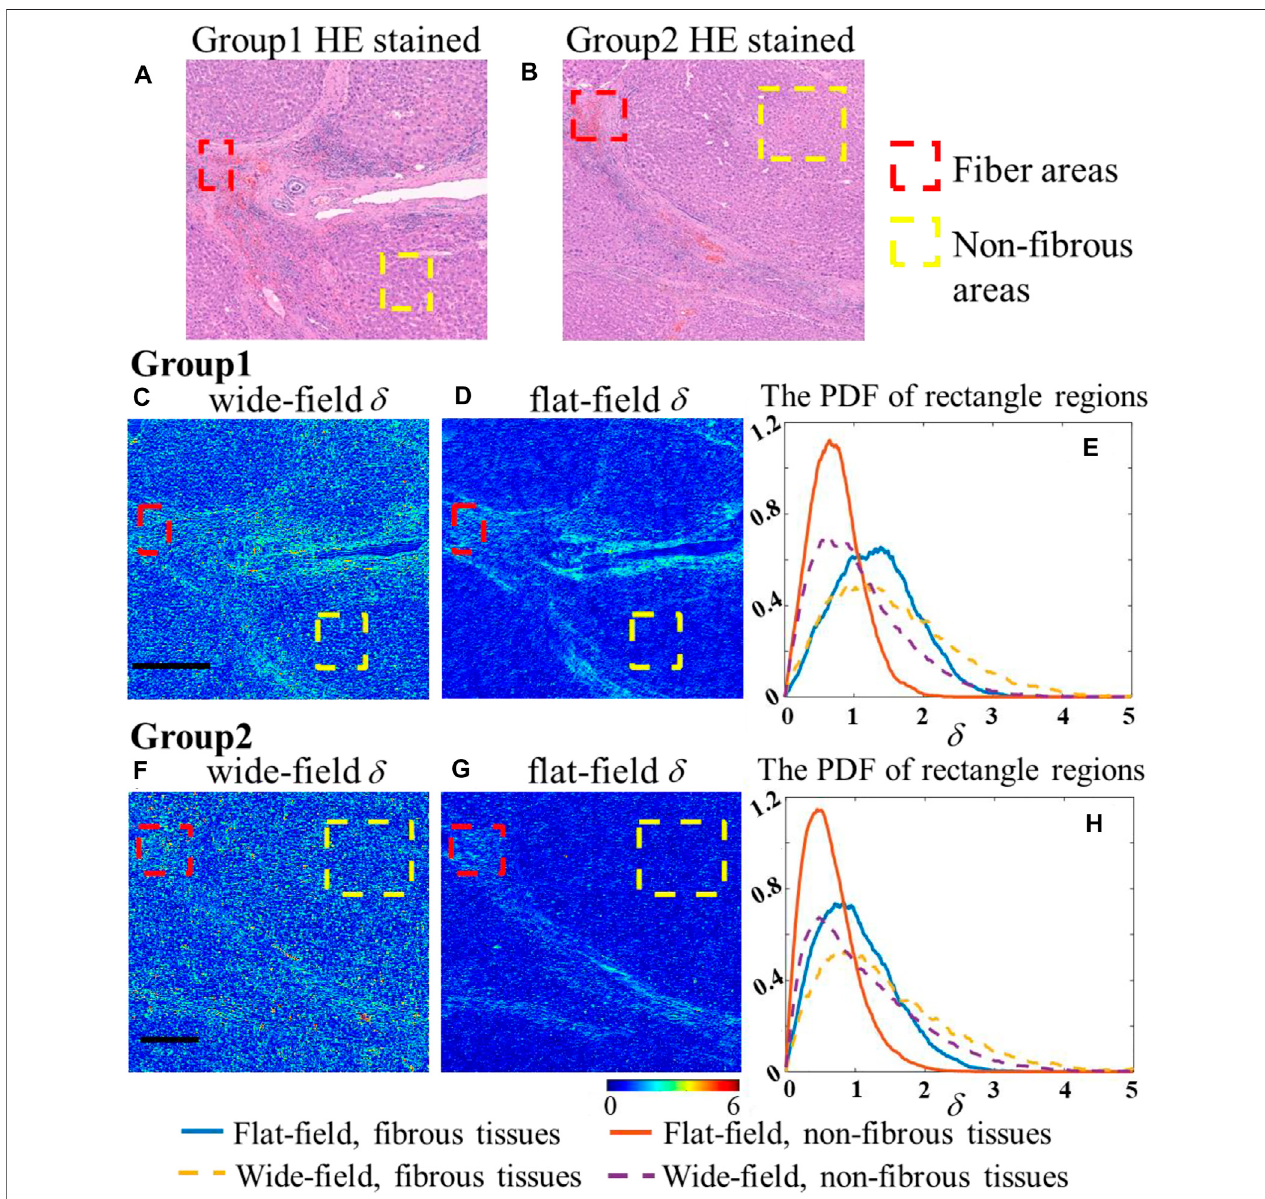
FIGURE10|(A-B) ChosenregionsoflivercirrhosisinHEstainedslices; (C-D) comparisonof δ ofgroup1intwosystems,respectively; (E) PDFof δ with fi bersand non- fi brous tissues in group 1, respectively; (F-G) comparison of δ of group 2 in two systems, respectively; (H) PDF of δ with fi bers and non- fi brous tissues in group 2, respectively; the black scale bar is 500 μ